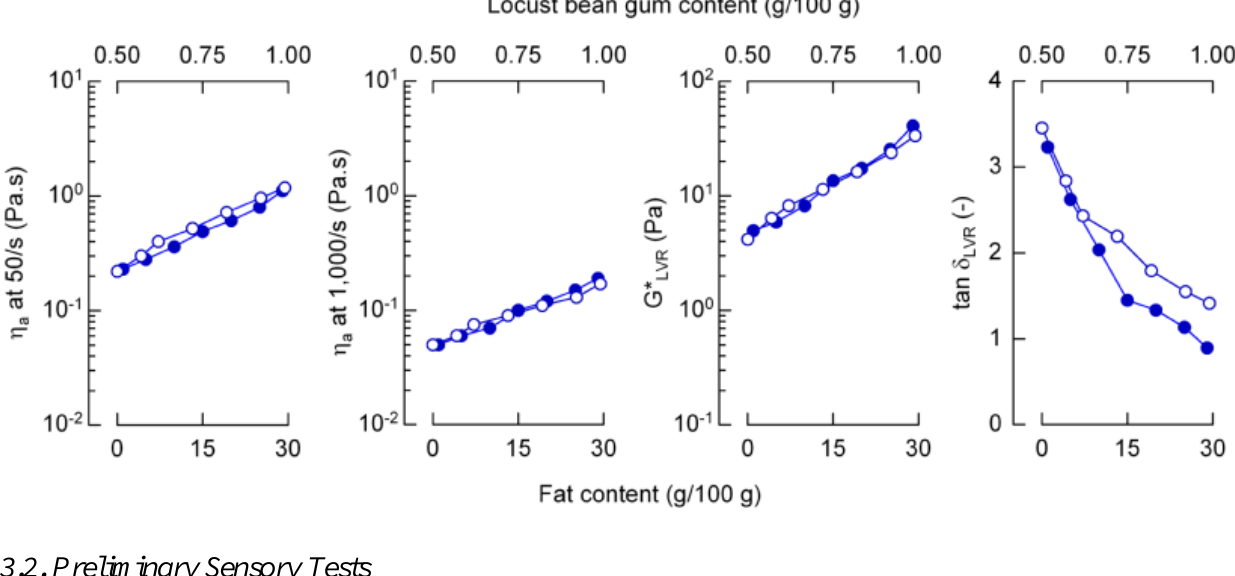
Figure 3. Apparent viscosity η the linear viscoelastic region of emulsions with different fat content (lower x -axis, closed symbols) and different locust bean gum content (upper x -axis, open symbols).